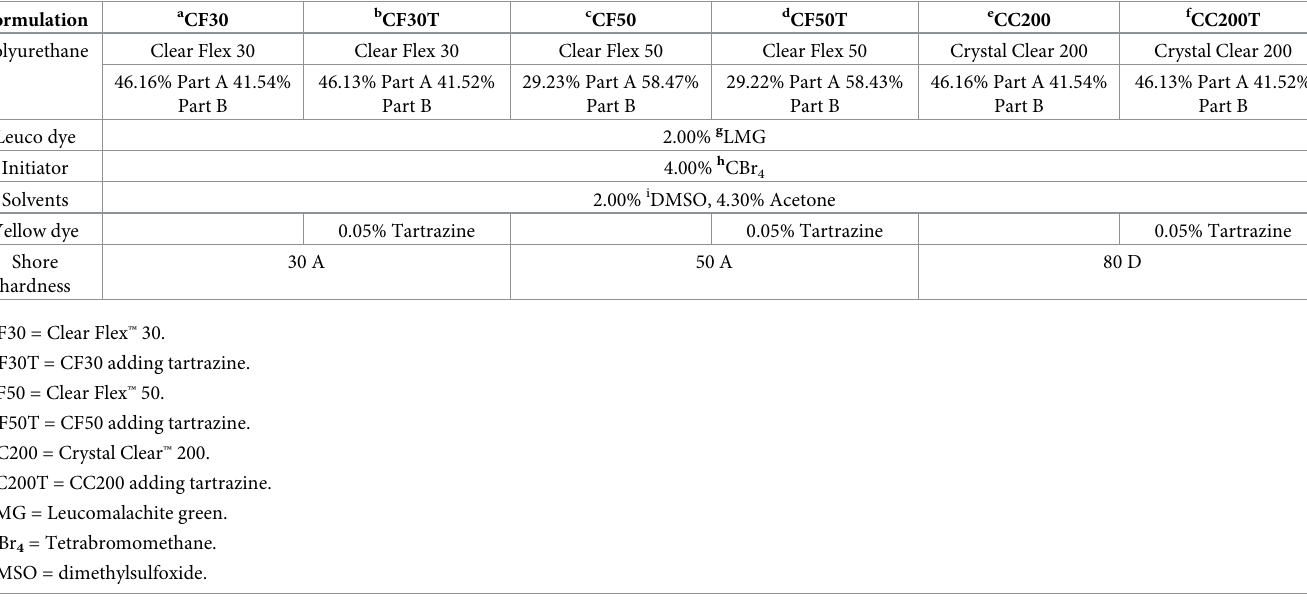
Table 1. Formulations for radiochromic polyurethane dosimeters. Percentages are by weight. Formulation names are based on formulation characteristics using